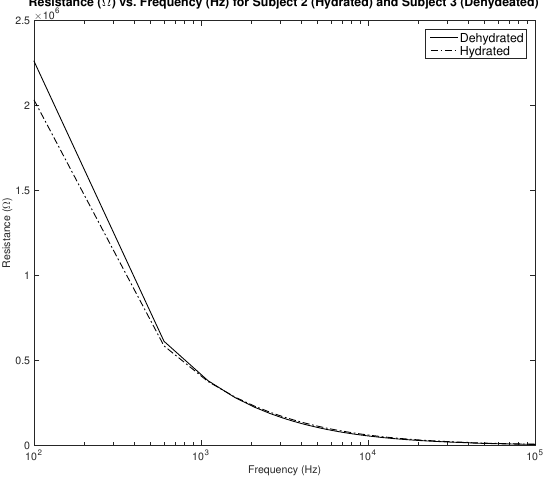
Figure 20. Testingresults—resistance( Ω )vs. frequency(Hz)ofhydratedanddehydratedsubjects(bothmale).